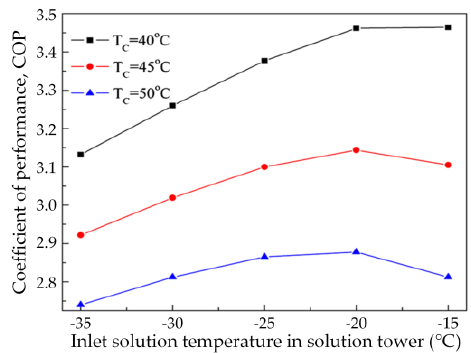
Figure 22. Effect of the temperature of inlet solution in solution tower on COP of FFASHP system [53].